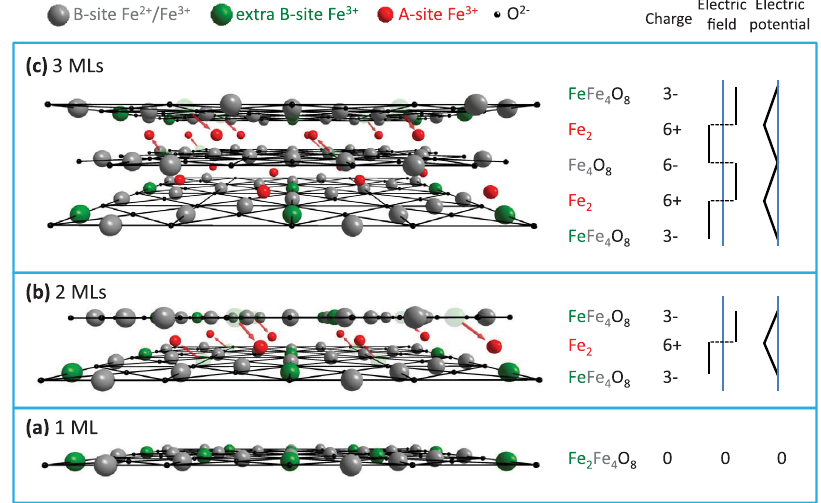
FIG. 4. Model for the growth process of polar Fe 3 O 4 (001) thin films. (a) One monolayer, (b) two monolayers, and (c) three